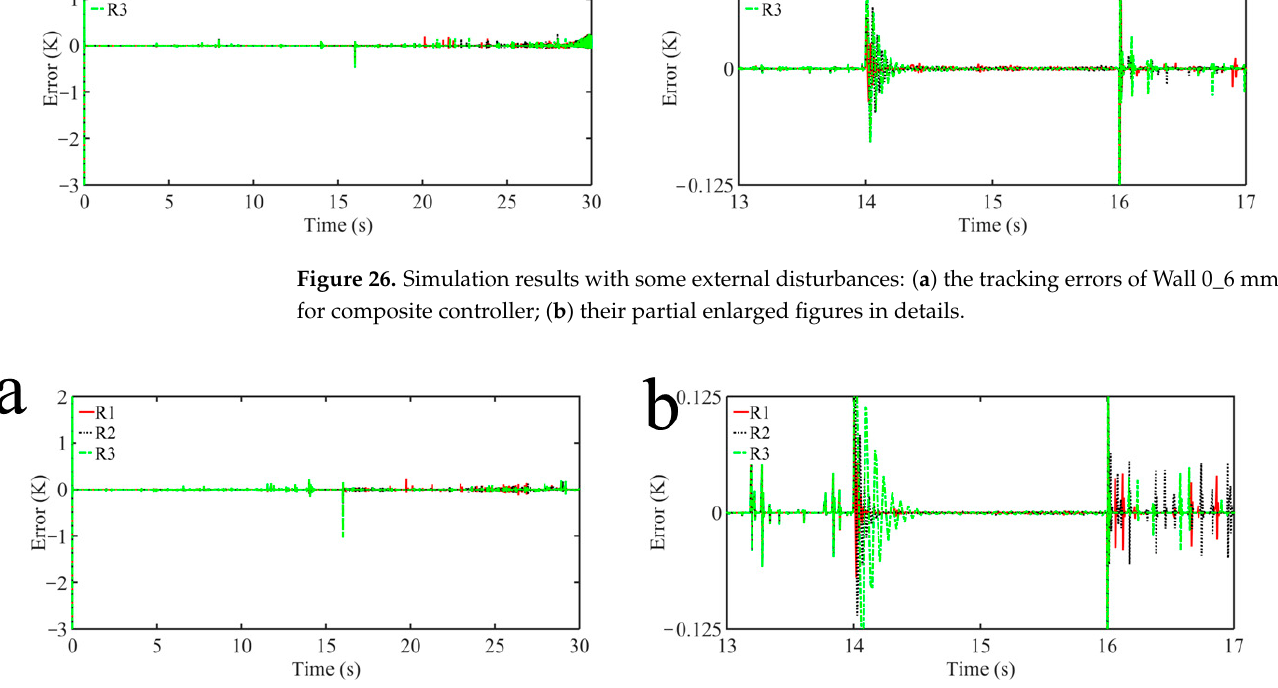
Figure 27. Simulation results with some external disturbances: ( a ) the tracking errors of Wall 1_5 mm for composite controller; ( b ) their partial enlarged figures in details.